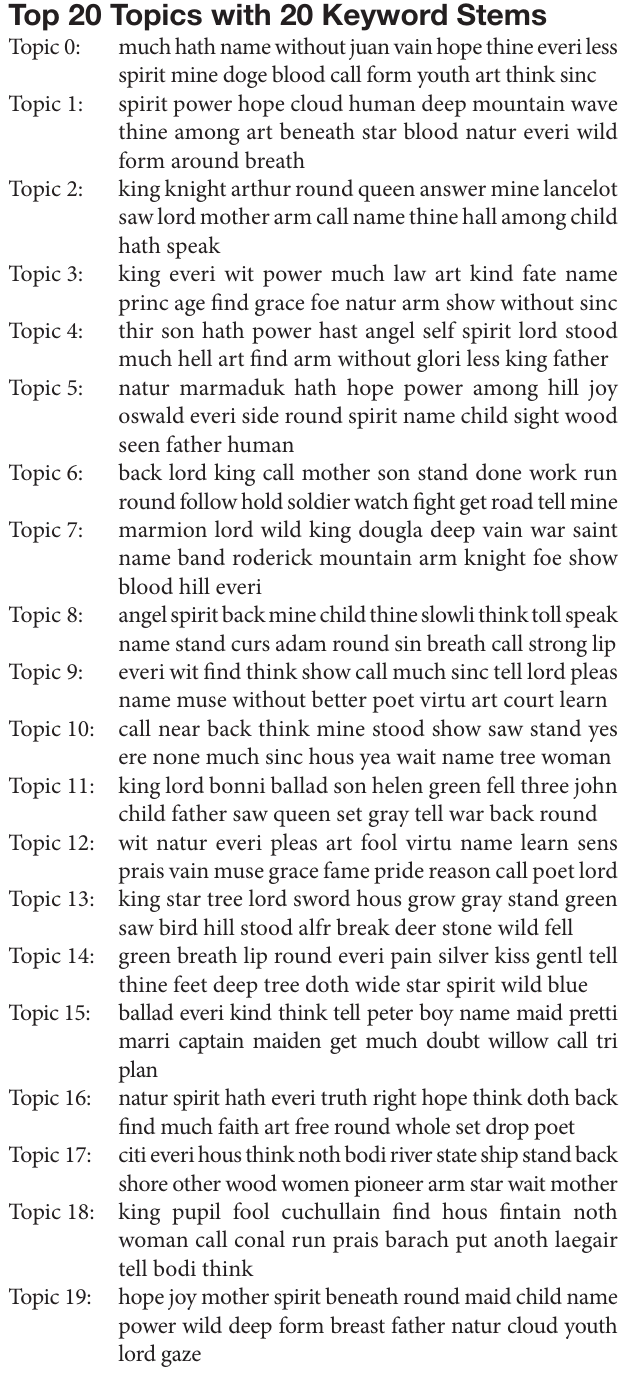
Table a1 | List of authors with example texts in the Gutenberg Literary English Corpus (GLEC) and total text lengths in the Gutenberg English Poetry Corpus